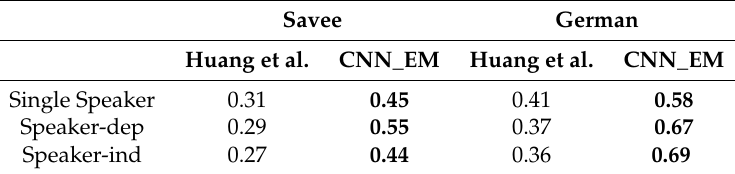
Table 4. Comparison of our scores against the results reported in [26], when evaluated on the RAW spectrograms. Numbers in bold indicate which method achieved highest performance in each experiment. Savee German Huang et al. CNN_EM Huang et al. Single Speaker